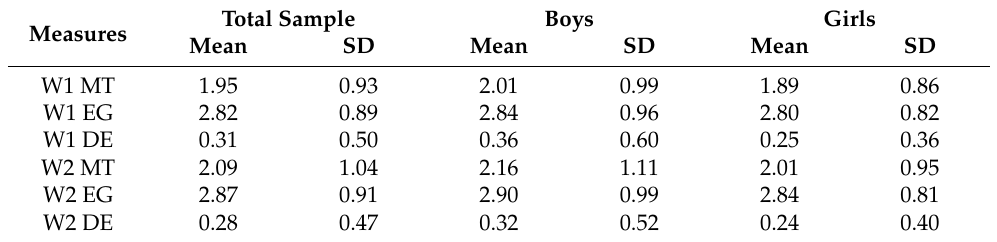
Table 1. Means and SD for the total sample and subsamples by gender (W1: N = 5690; W2: N = 4981). Measures